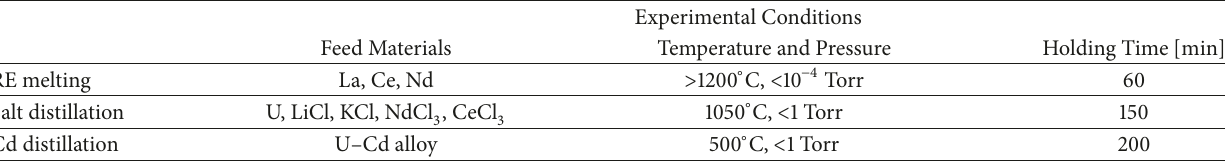
Table 1: Experimental conditions for the tests of W